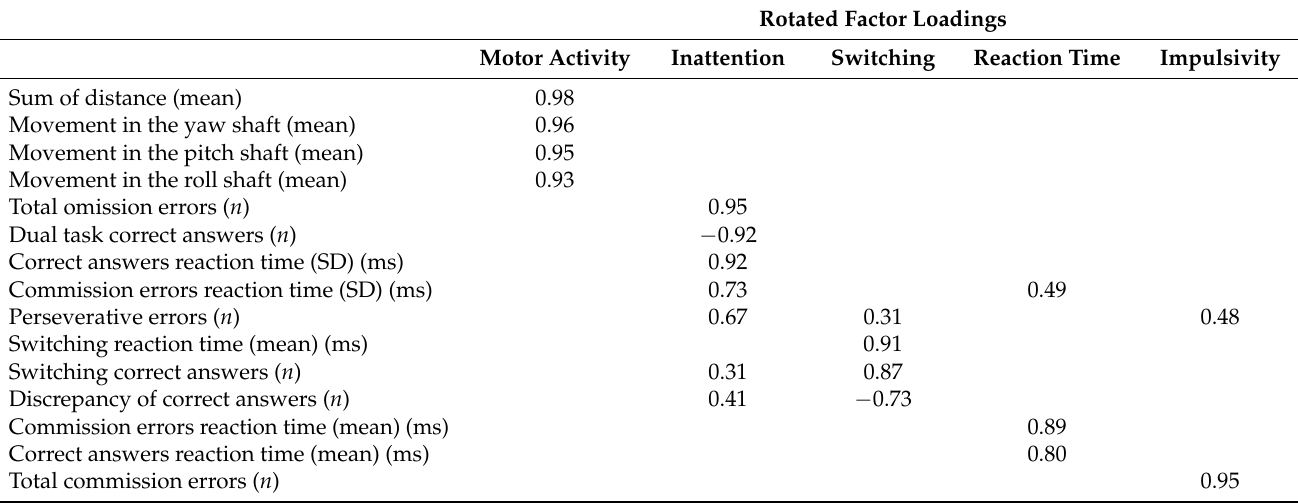
Table 2. Rotated Factor